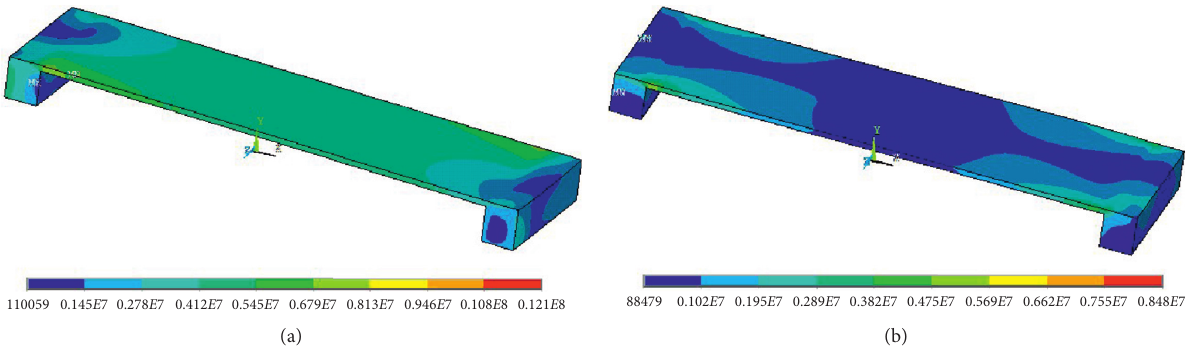
Figure 23: Von Mises equivalent stress distributions on the main girder section for the repair cases (unit: Pa): (a) repair scheme 1 and (b) repair scheme 2.